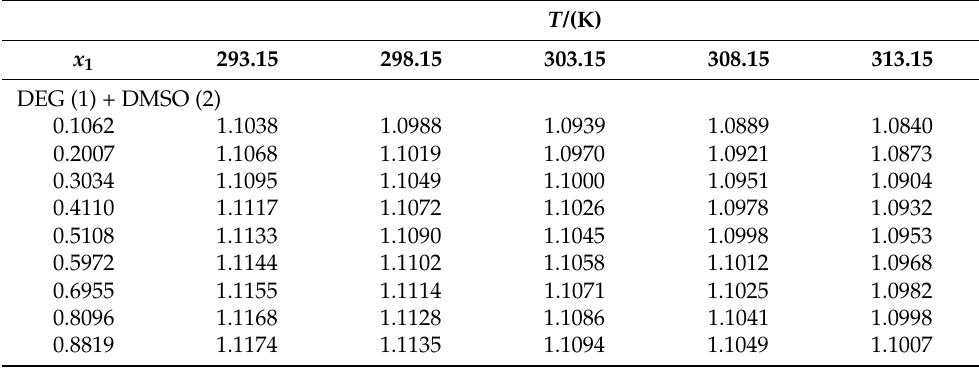
Table 3. Density values ρ /(g · cm − 3 ) as a functions of mole fraction in the temperature range from 293.15 to 313.15 K and at atmospheric